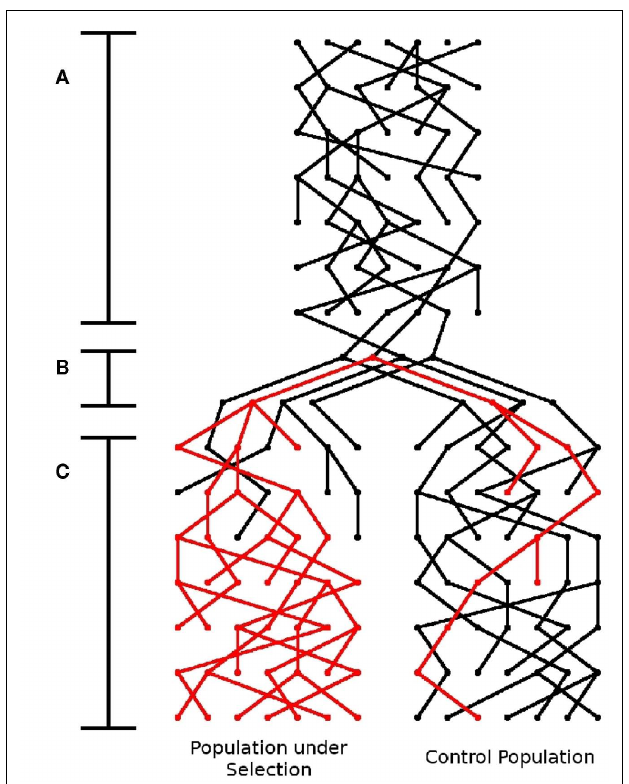
FIGUREA6 | Schematic of simulator. There are three stages to this simulator: (A) Generation of founder population, (B) Shrinking of population to “founders , ” introduction of the beneficial mutation (represented by the red lineage), and separation into sub-populations, and (C) Application of selection pressure in one subpopulation and